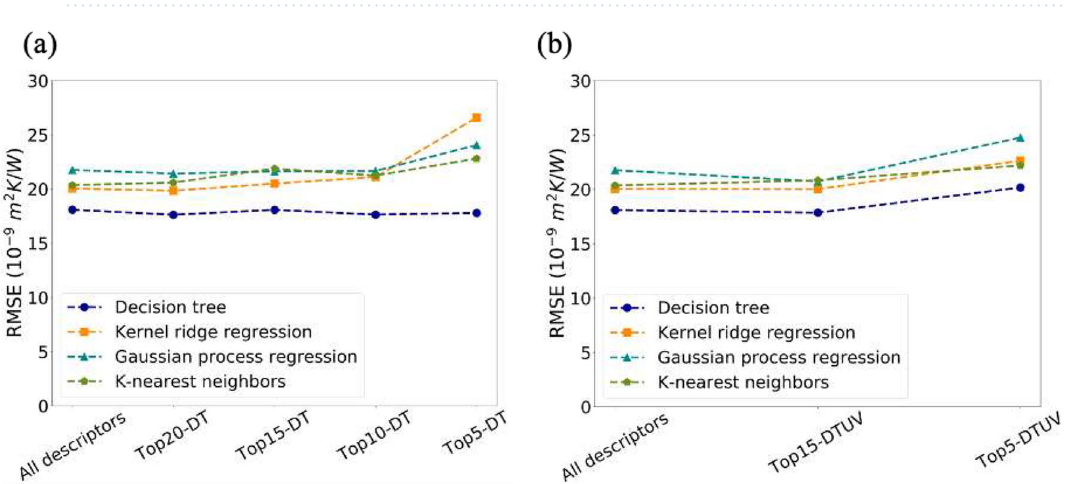
Figure 6. ( a ) RMSE of validation set by models built by descriptors selected by decision tree under grouped cross-validation. ( b ) RMSE of validation set by models built by common descriptors selected by decision tree and univariate testing under grouped